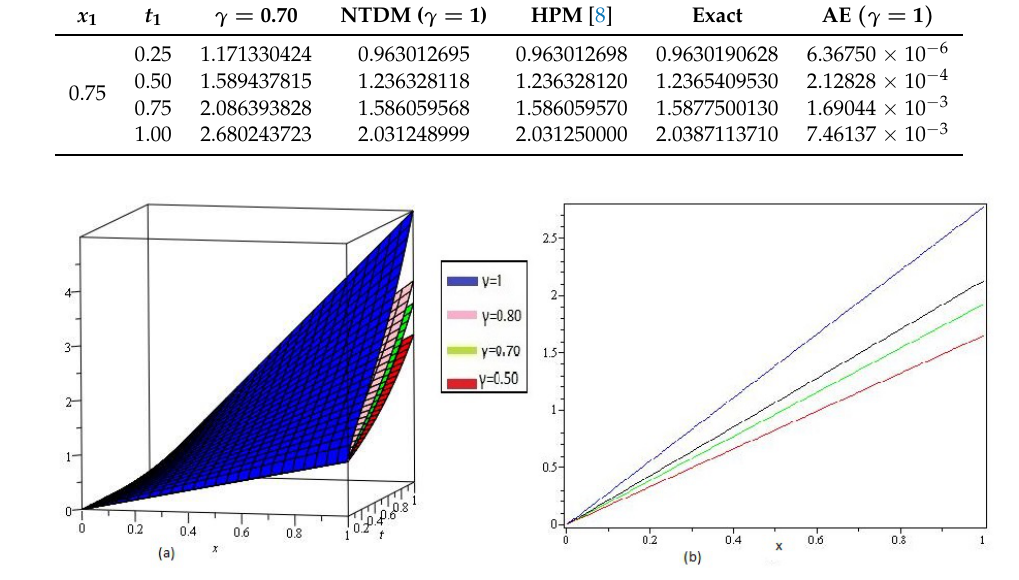
Figure 1. Numerical results of Example 1, for different value of γ and t = 1.